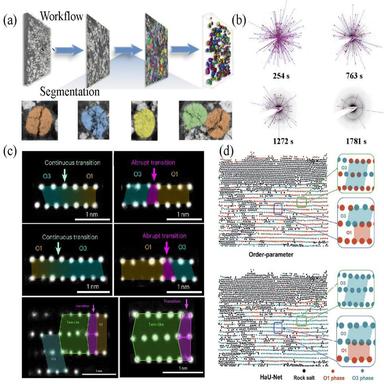
(a) ML-based segmentation and labeling. Reproduced with permission from Ref. . Copyright 2020, Springer Nature. (b) The representative diffraction patterns of Co3O4 at 254, 763, 1272, and 1781 s. Reproduced with permission from Ref. . Copyright 2022, Wiley. (c) ML enhanced characterizations of atomic configurations of two types of O1-O3 interface and the twin-like domains coexisting with the O1 phase. Reproduced with permission from Ref. . Copyright 2023, Springer Natu